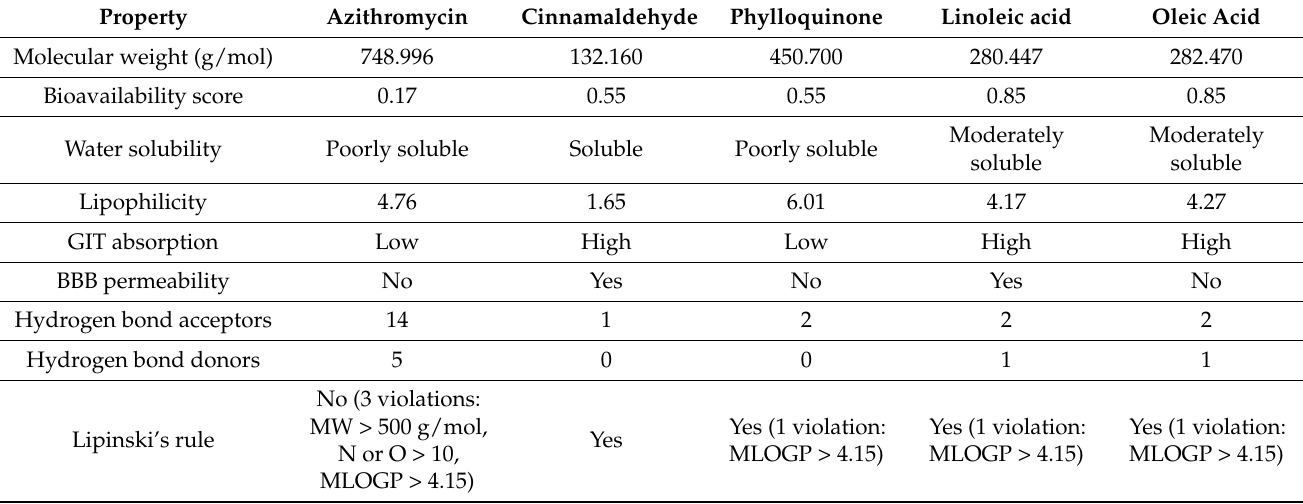
Table 9. Cheminformatics properties of the top-ranked compounds against